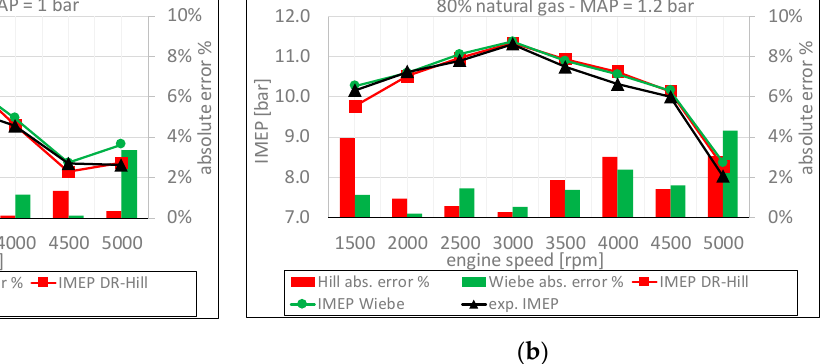
Figure 6. comparison between the experimental and simulated IMEP; 80% NG fuel mixture. ( a ) MAP = 1 bar; ( b ) MAP = 1.2 bar.